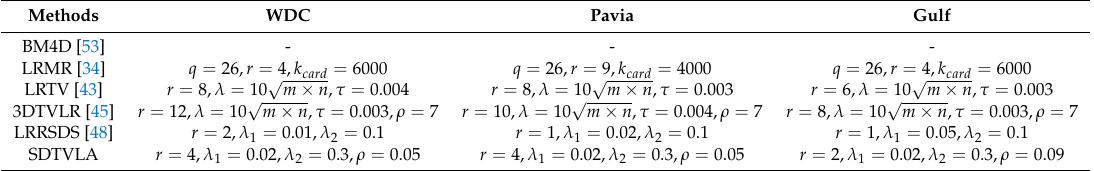
Table 1. Optimal parameters of the comparison algorithms on the simulated HSI